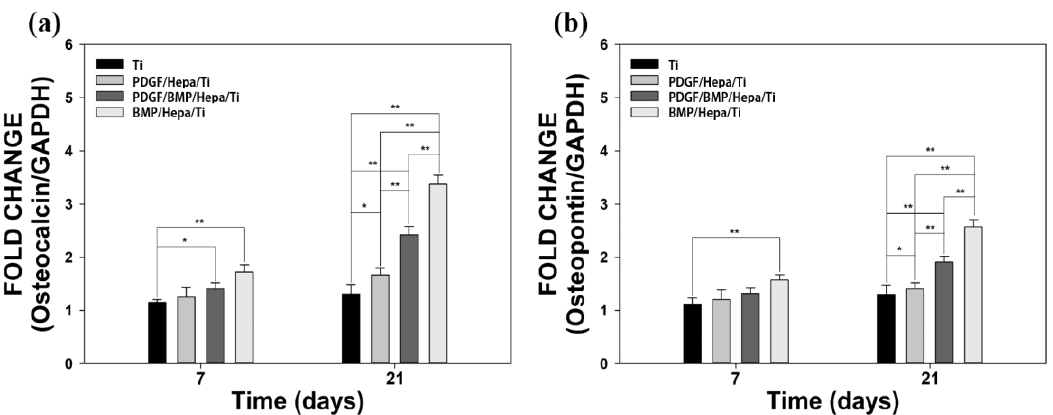
Figure 6. Real-time PCR analysis of the mRNA levels of ( a ) osteocalcin and ( b ) osteopontin in cells grown on Ti, PDGF/Hepa/Ti, BMP/Hepa/Ti, or PDGF/BMP/Hepa/Ti discs for 7 or 21 days (* p < 0.05 and ** p < 0.01).